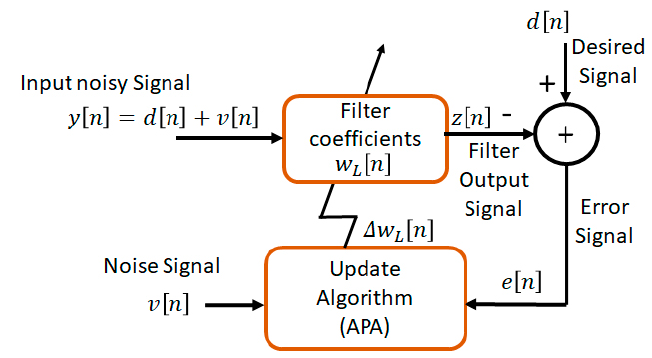
Figure 5. The general structure of the adaptive filter for denoising applications.